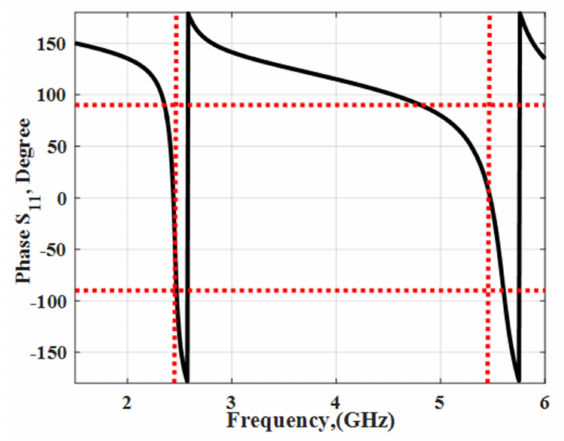
Figure 8. The phase of S 11 results in AMC structure.